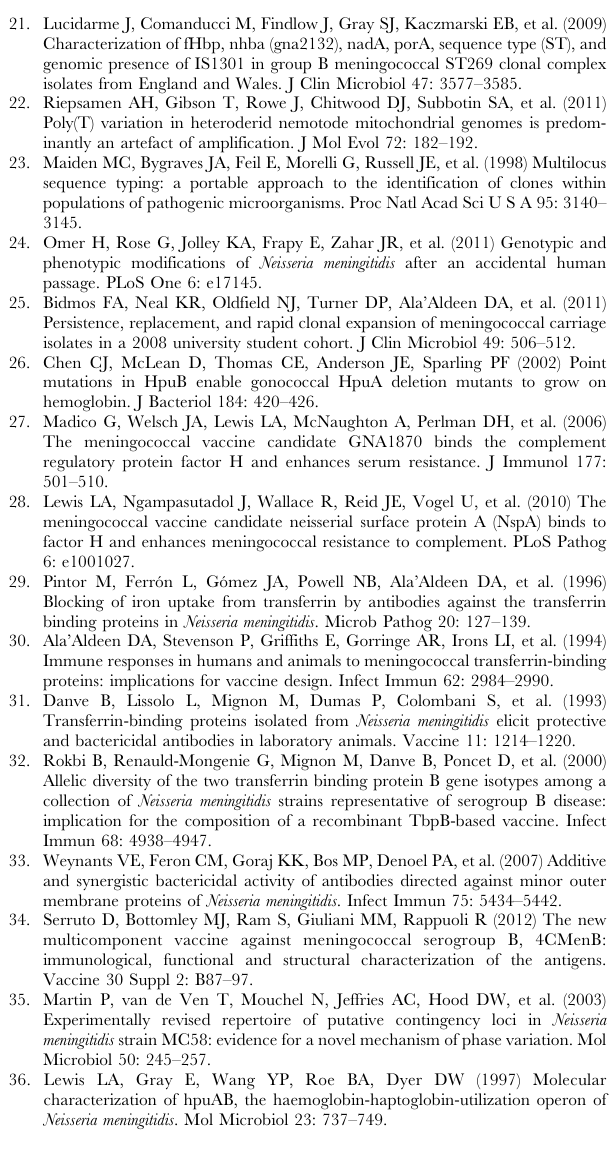
Table S1 Genotypic and phenotypic phase variation status of hmbR and hpuA among a representative panel of English, Welsh and Northern Irish invasive serogroup B meningococcal isolates and their corresponding clinical specimens. a Presence of at least one gene in the ON configuration (ON = at least one gene present in ON configura- tion; OFF= no genes in ON configuration). b Ability to utilise Hb as sole iron source. c Isolate contained . 18 homopolymeric tract repeats. d Poor growth on Mueller Hinton agar or uncertainty regarding growth status. e Specimen did not yield detectable PCR products at reduced number of PCR cycles. f Indicates whether ST is centred upon ST-269 (269) or ST-275 (275) by